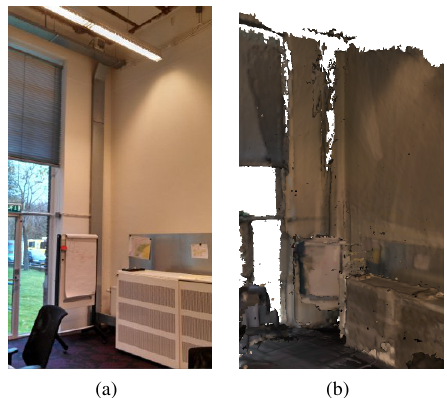
Figure 5: Problem with high ceilings. (a) University of fi ce with a high ceiling. (b) Model obtained with the